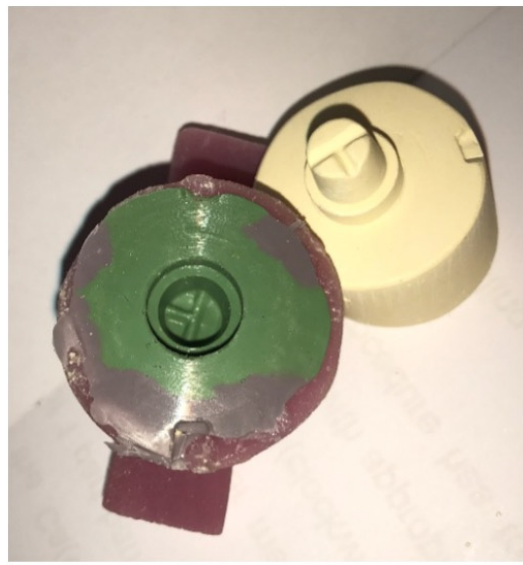
Figure 1. Master model.